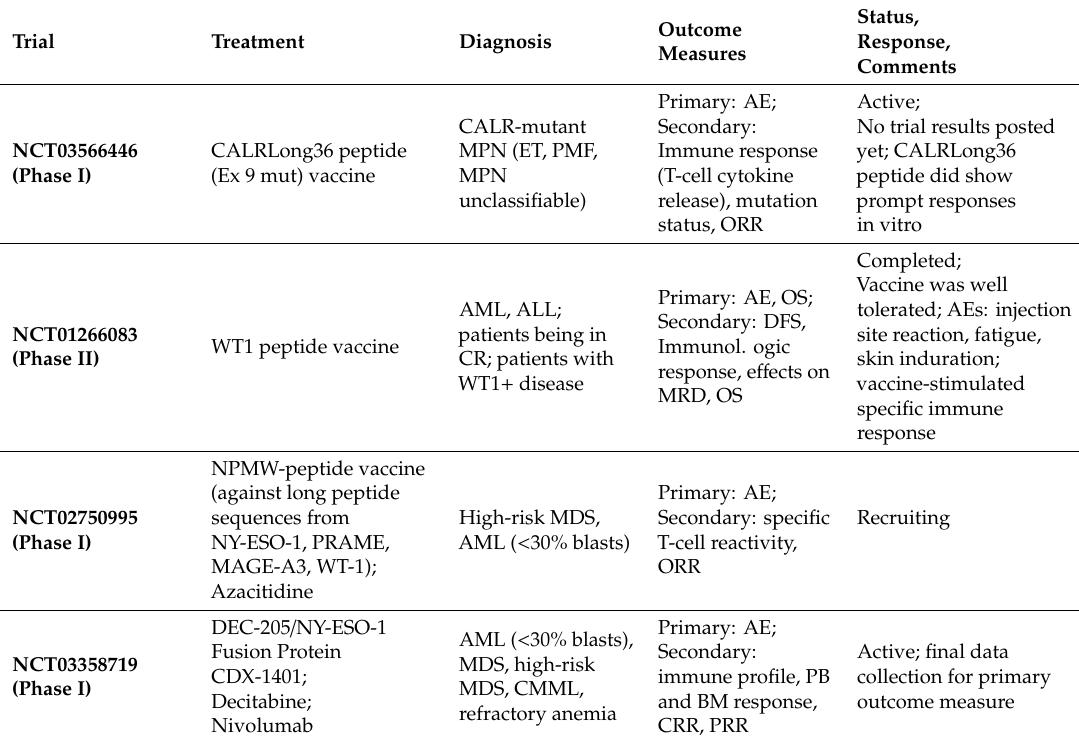
Table 3. Selected Clinical Trials investigating tumor vaccination in myeloid malignancies. Trial Treatment Diagnosis